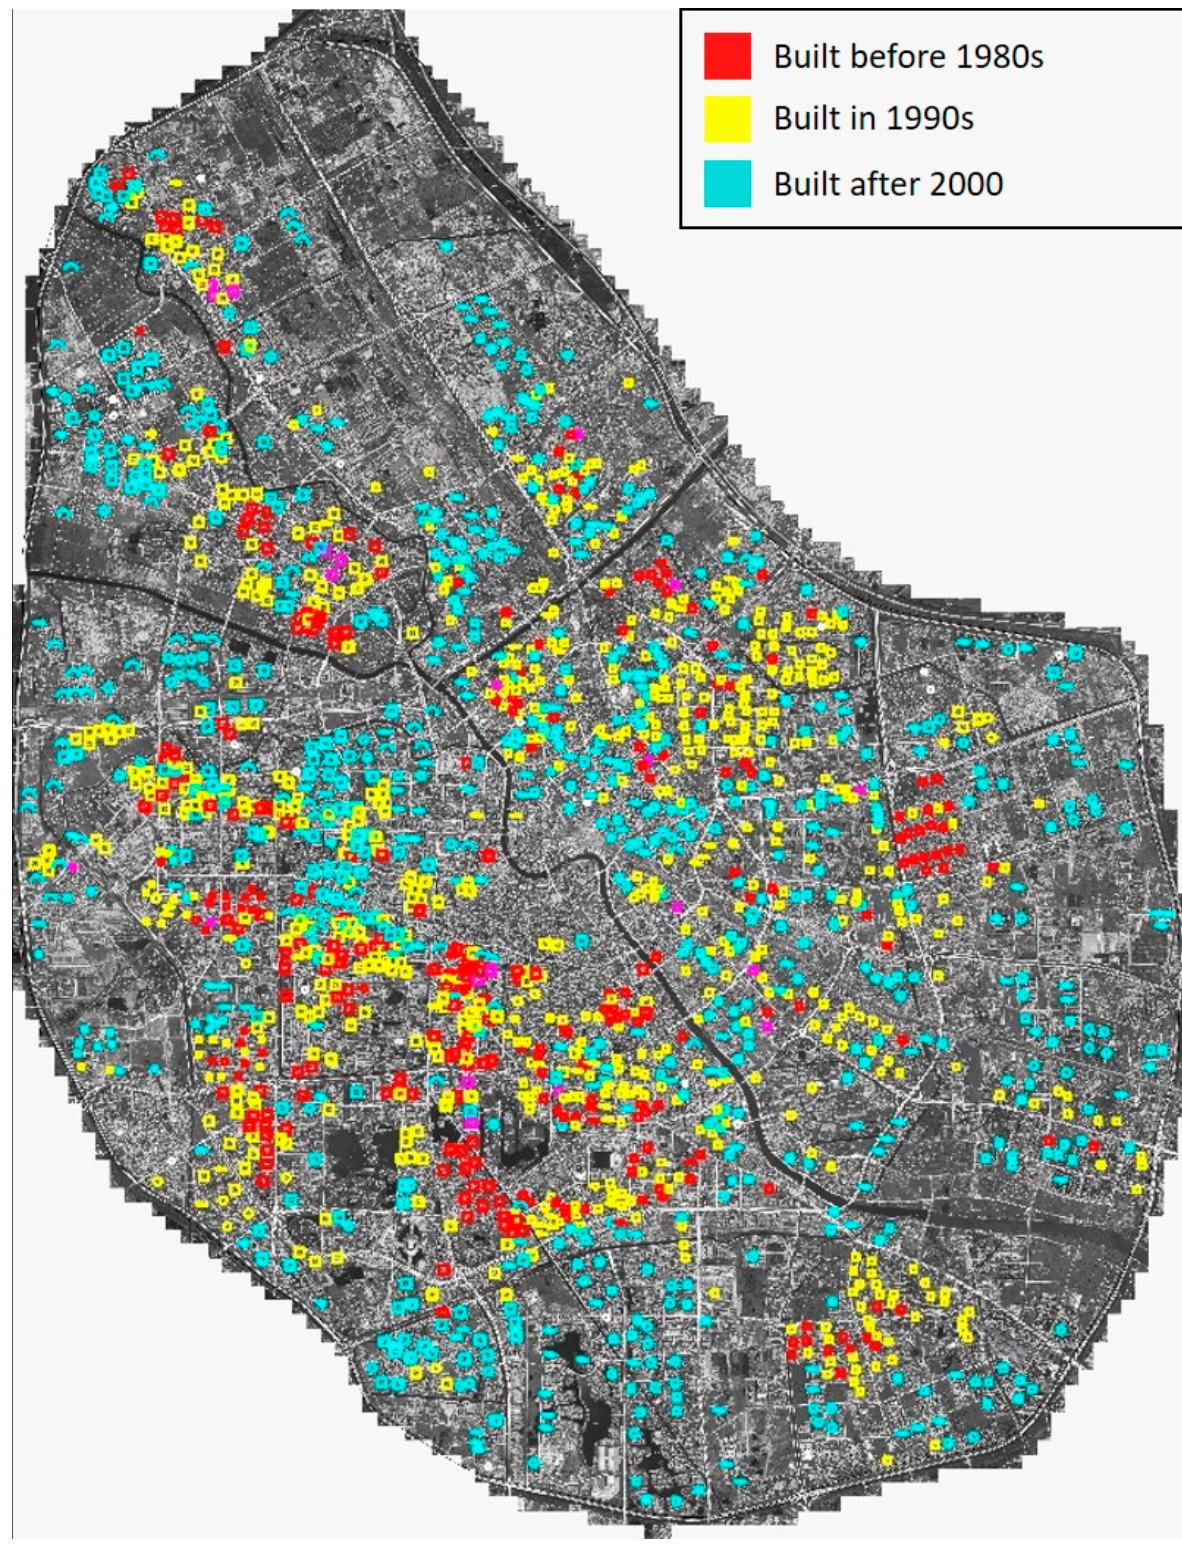
Figure 1. Distribution of Tianjin’s URAs according to building ages.